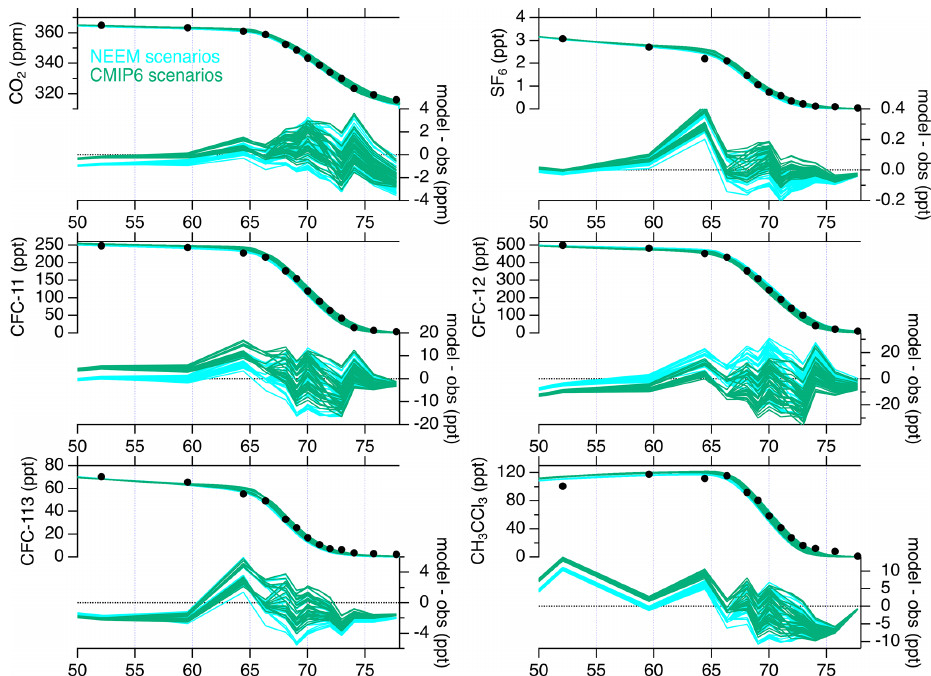
Figure 7. Same as Fig. 6 but for a comparison of the modelled profiles in the NGRIP firn with different atmospheric scenarios of BZ and CMIP6, which are shown in light blue and green, respectively. Only the simulation results with RMSD values of < 1.0 are shown.